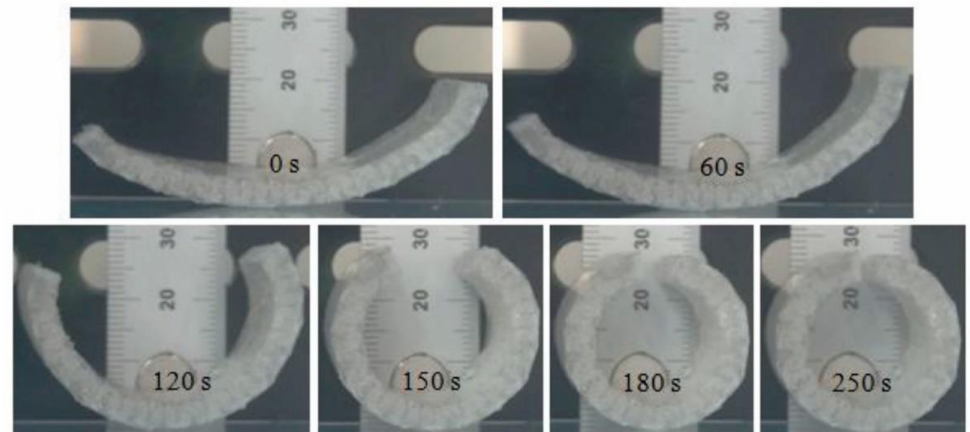
Figure 22. Shape memory behavior of an open 4D-printed braided tube preform/silicone elastomer matrix composite with the braiding angle of 30 ◦ and three braiding layers at the shape recovery temperature of 70 ◦ C (Reproduced with permission from Reference [175], copyright 2018,